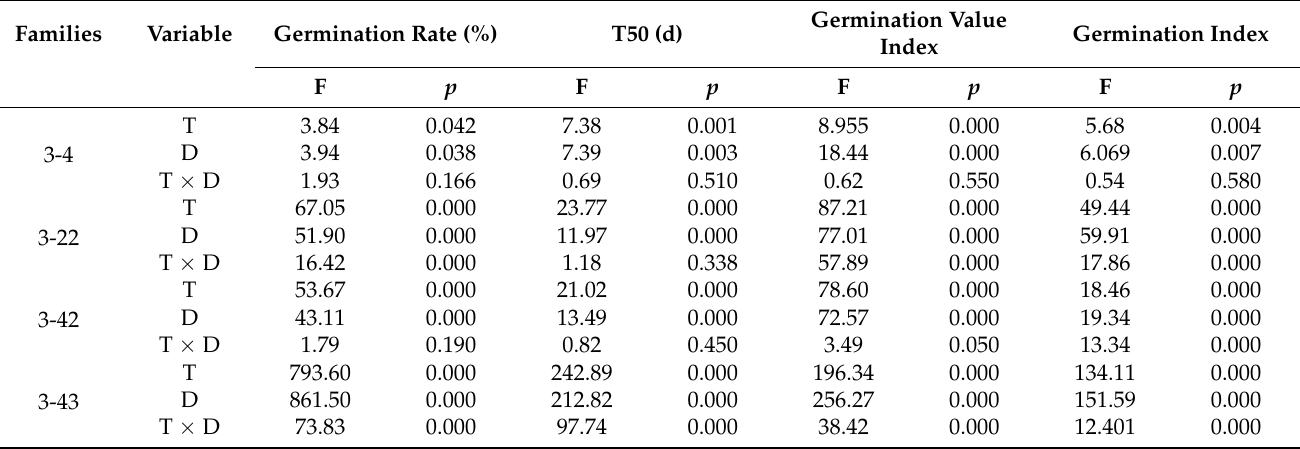
Table 3. Two-way ANOVA on the effect of temperature and drought and their interaction on seed germination in different families of Betula